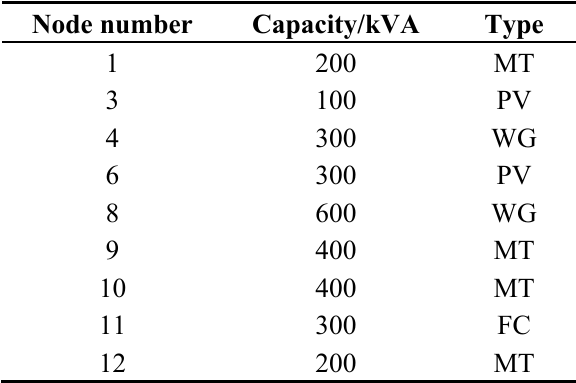
Table 5. The optimization result of DG.